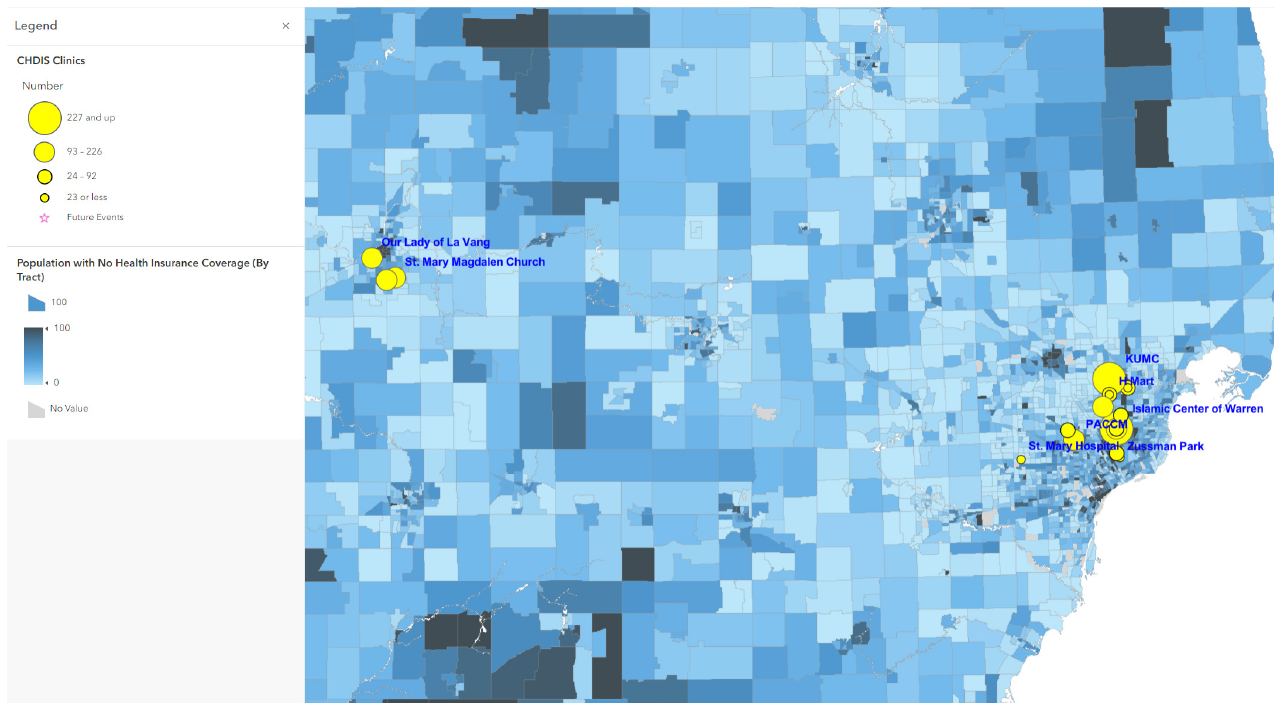
Figure 3. EMU mobile clinics vs. Michigan overall population COVID-19 vaccine completion per- centage by county.